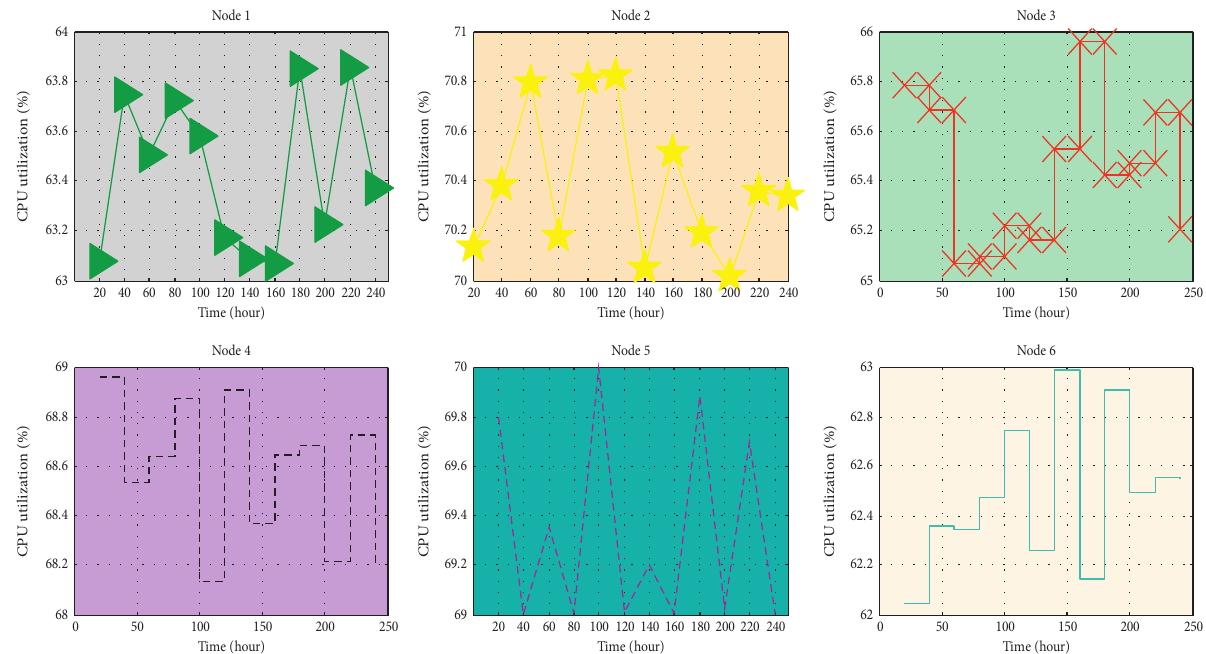
Figure 8: CPU monitoring after adding nodes 1 to 6.